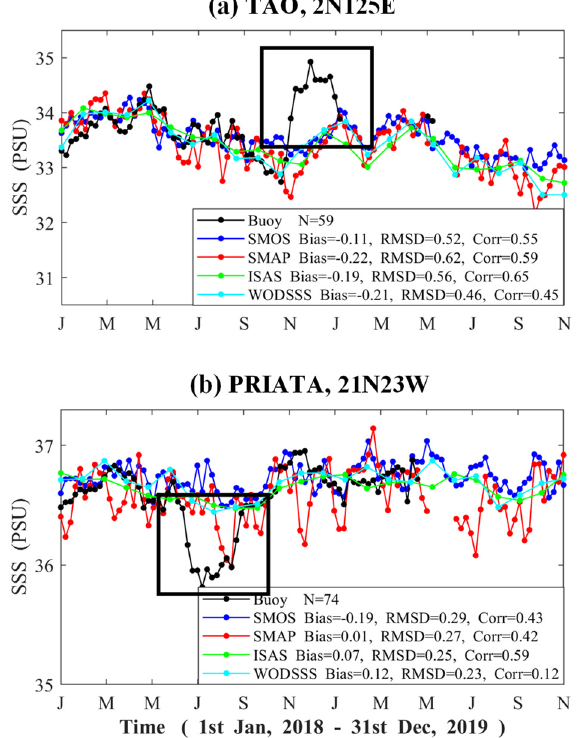
Figure 15. Time series of (a) problematic buoy salinity at 1 m depth (black), collocated daily SMOS (blue) and 8-day SMAP (red), SSS plotted with monthly in situ data from WODSSS (azure) and APDRC (blue). Data are from (left) TAO at 2° N, 125° E and (right) PIRATA at 21° N, 23° W.